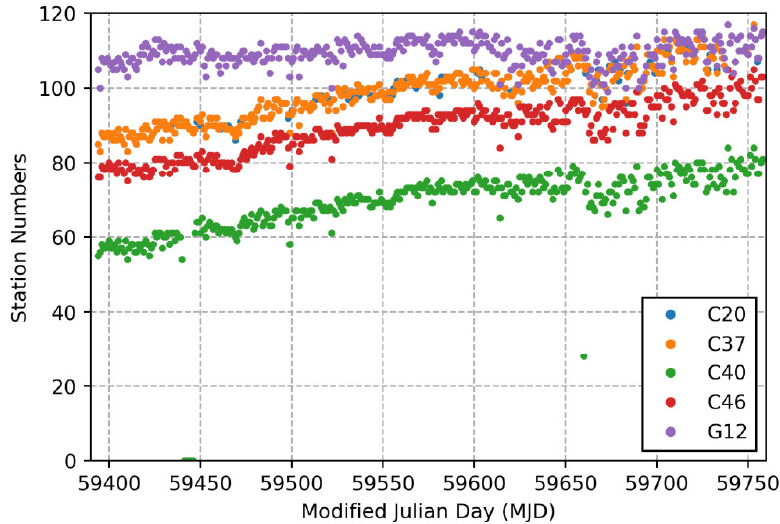
Figure 3. Daily number of stations used for the data processing of the selected BDS satellites (C20, C37, C40, C46) and GPS satellite G12, the signal frequencies pair are B1C/B2a for BDS and L1/L2 for